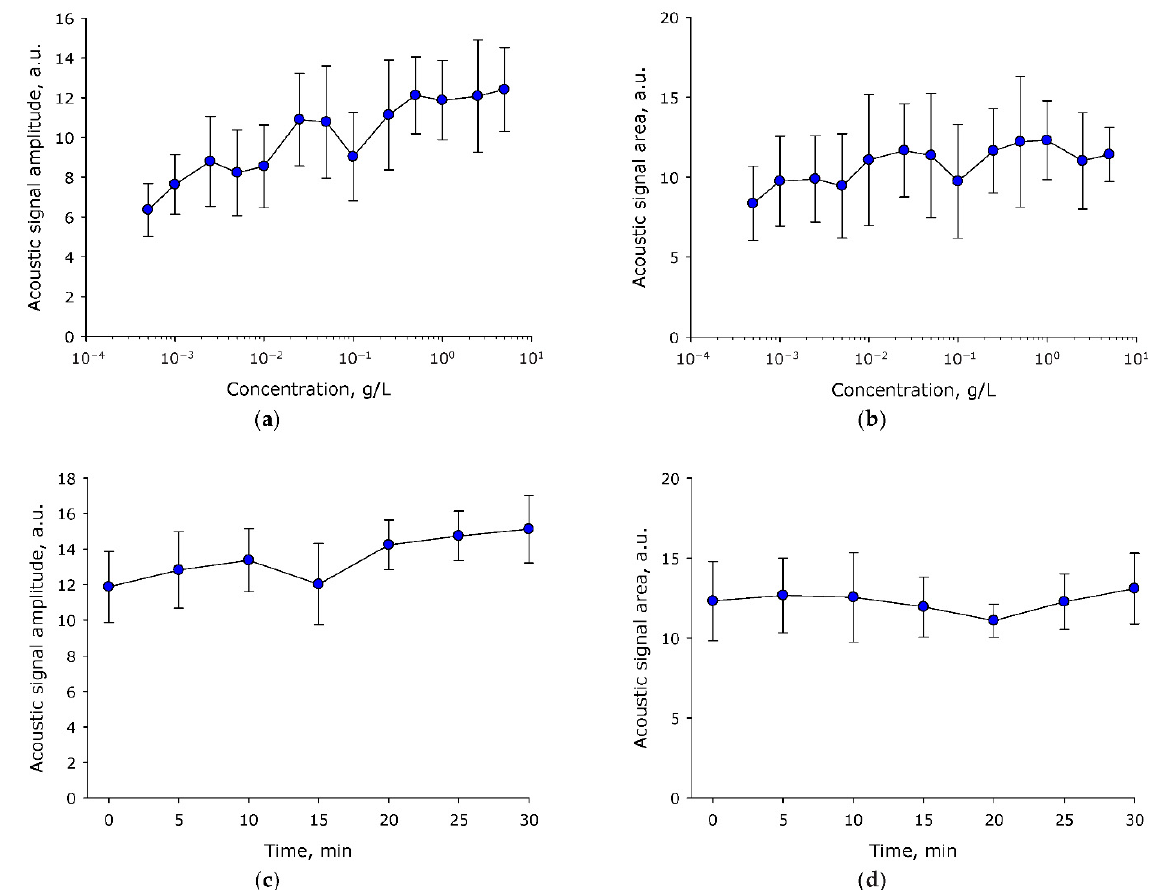
Figure 3. Influence of BSA aqueous solution irradiation time and its concentration on the charac- teristics of acoustic oscillations induced by optical breakdown ( n = 3, Mean ± SEM). ( a ) Effect of the concentration of BSA molecules in aqueous solution on the average amplitude of acoustic vibra- tions induced by optical breakdown. ( b ) Effect of the concentration of BSA molecules in aqueous solution on the average intensity of acoustic vibrations induced by optical breakdown. ( c ) Effect of the time of irradiation of aqueous solution of BSA (1 mg/mL) with a laser on the average amplitude of acoustic oscillations induced by optical breakdown. ( d ) Influence of the time of irradiation of aqueous solution of BSA (1 mg/mL) with a laser on the average intensity of acoustic oscillations induced by optical breakdown.